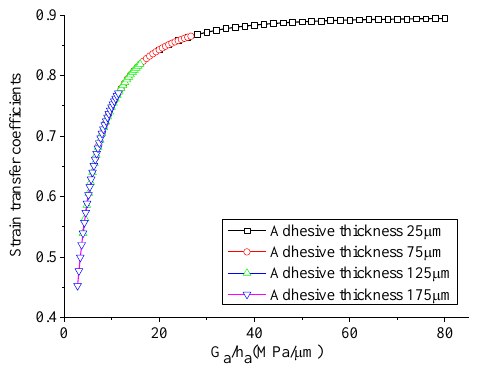
Figure 8. The strain transfer coefficient at the middle of PZT versus the shear modulus of adhesive in the theoretical model.